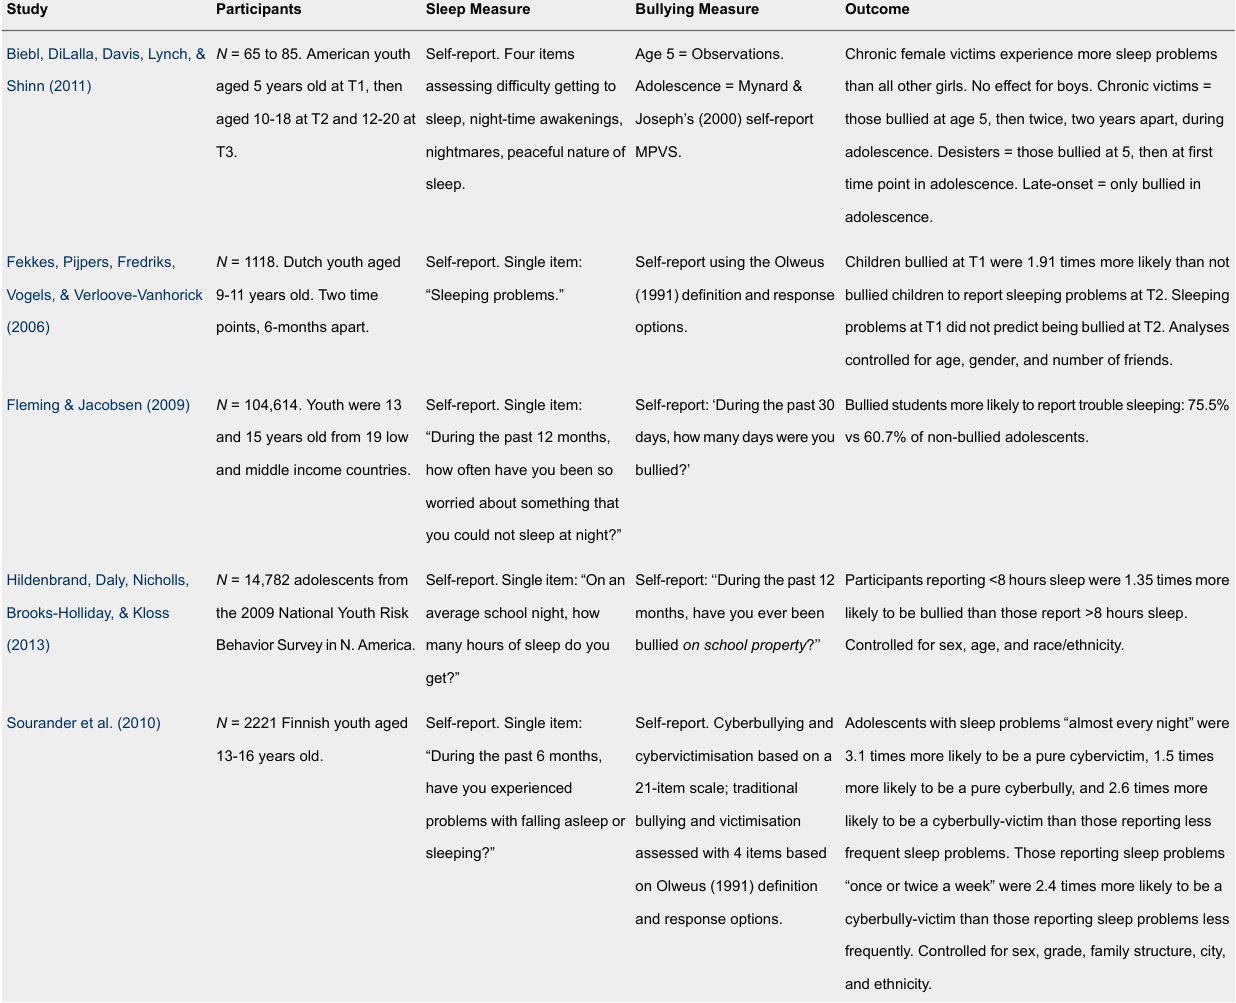
Studies Evaluating Associations Between Bullying Involvement and Sleep Difficulties